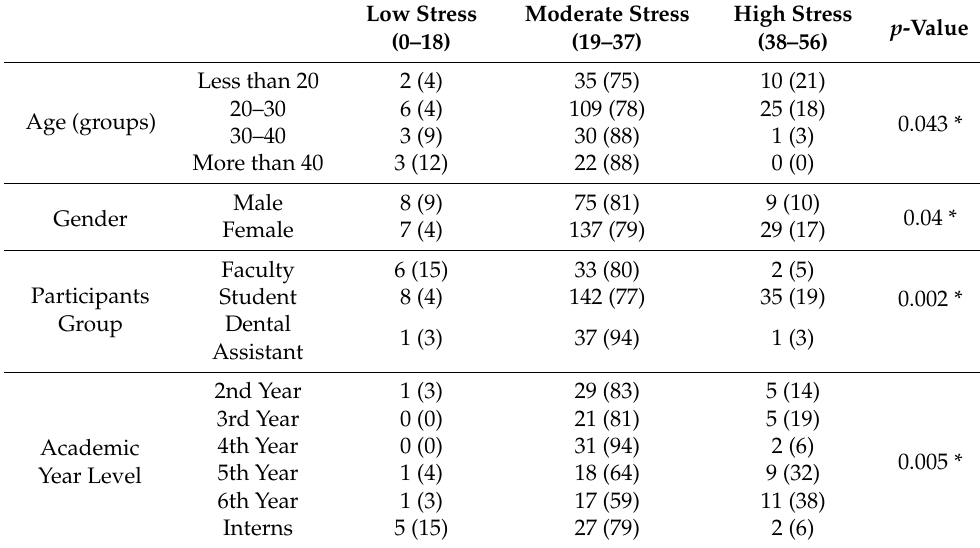
Table 2. Showing stress levels of the participants involved in our study. Stress levels are presented as mean (SD).